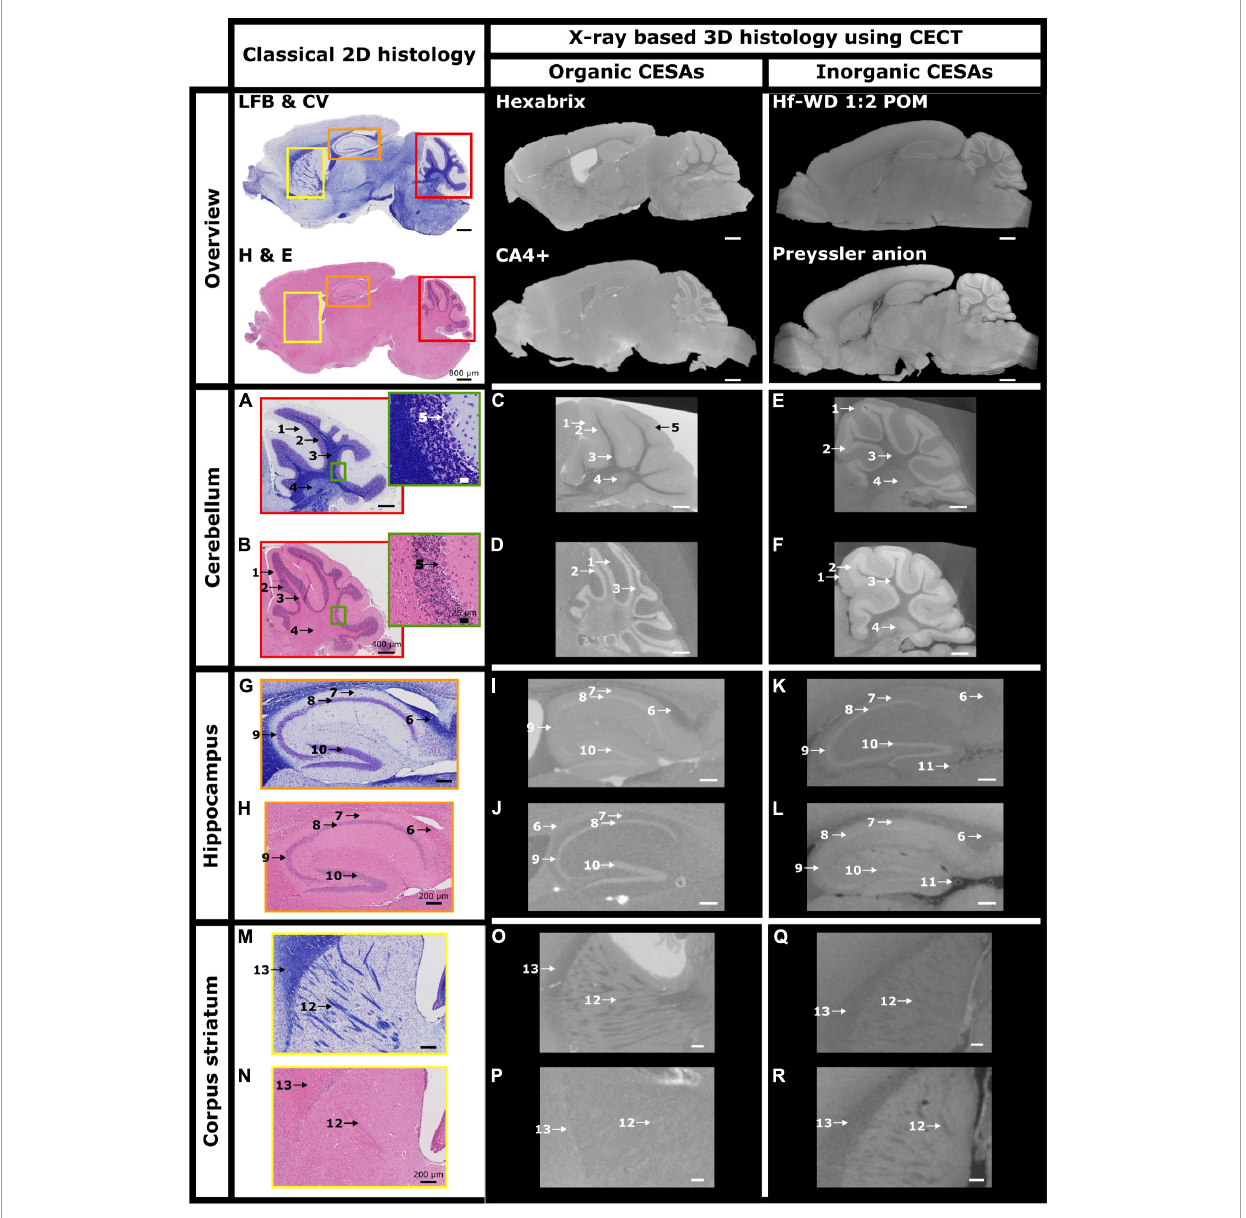
FIGURE5 Investigation of CESA distribution throughout the murine hemisphere. Overview and zoom on cerebellum, hippocampus and corpus striatum of cross-sections of murine hemispheres stained by LFB & CV (A,G,M) , H&E (B,H,N) , Hexabrix (C,I,O) , CA4+ (D,J,P) , Hf-WD 1:2 POM (E,K,Q) , and Preyssler anion (F,L,R) . 1 = molecular layer, 2 = granular layer, 3 = white matter, 4 = cerebellar nuclei, 5 = Purkinje cell layer, 6 = corpus callosum, 7 = stratum oriens, 8 = stratum pyramidale (CA1), 9 = stratum pyramidale (CA2 and/or CA3), 10 = stratum granulare (Dentate gyrus), 11 = blood vessel, 12 = Striatopallidal fiber bundles, 13 = corpus